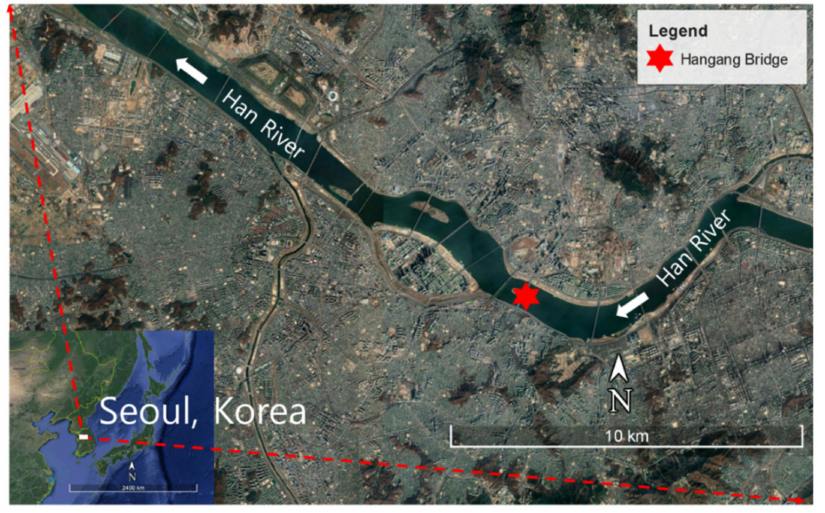
Figure 6. Map of the Han River basin in Korea (Google Earth